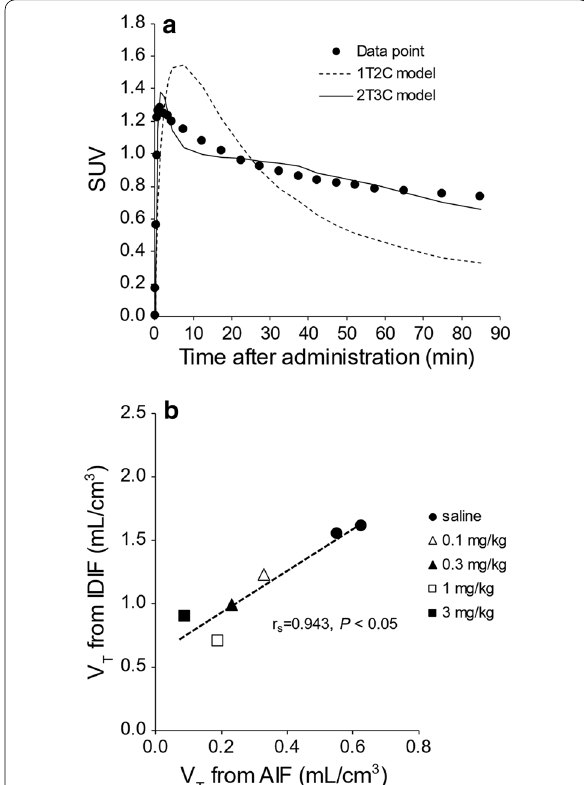
Fig. 5 Curve fitting for the compartment analysis and correlation analysis with V T . a Quality of curve fitting for a representative hepatic time-activity curve and b correlation between V T obtained using IDIF and V T obtained using AIF. Saline or unlabelled RGD (0.1, 0.3, 1, or 3 mg/kg) were administered intravenously 5 min before